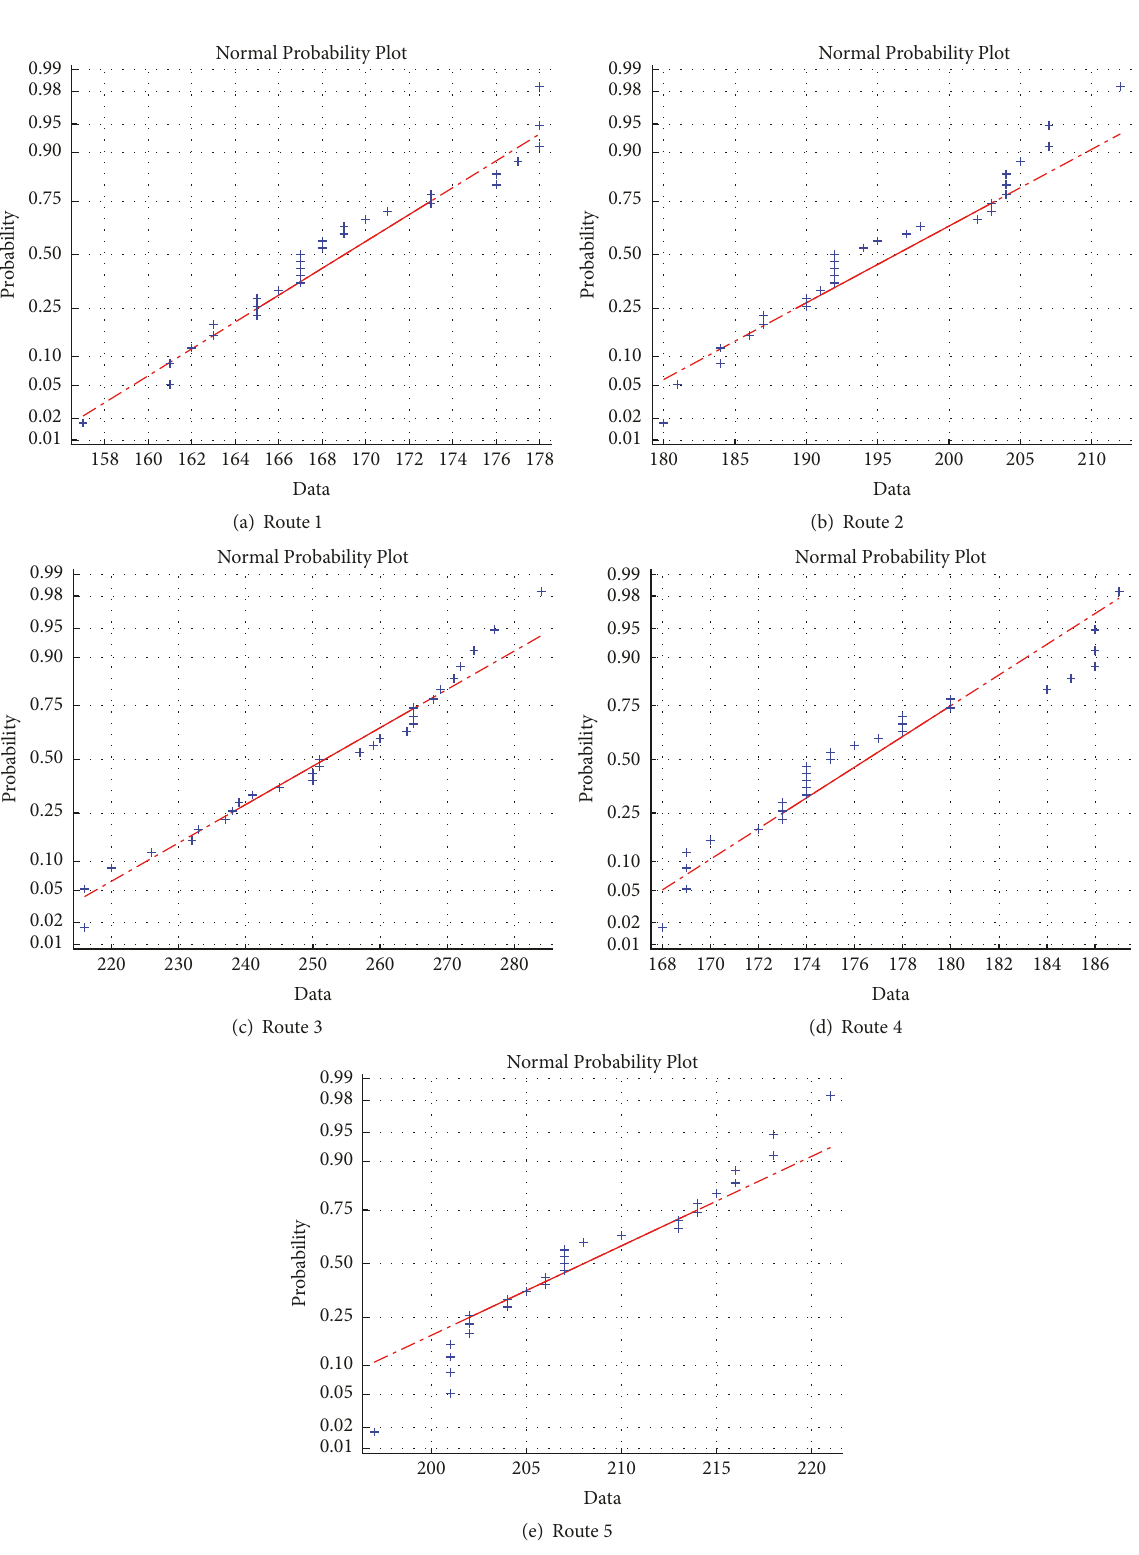
Figure 10: Normal distribution test for the equilibrium volume of each